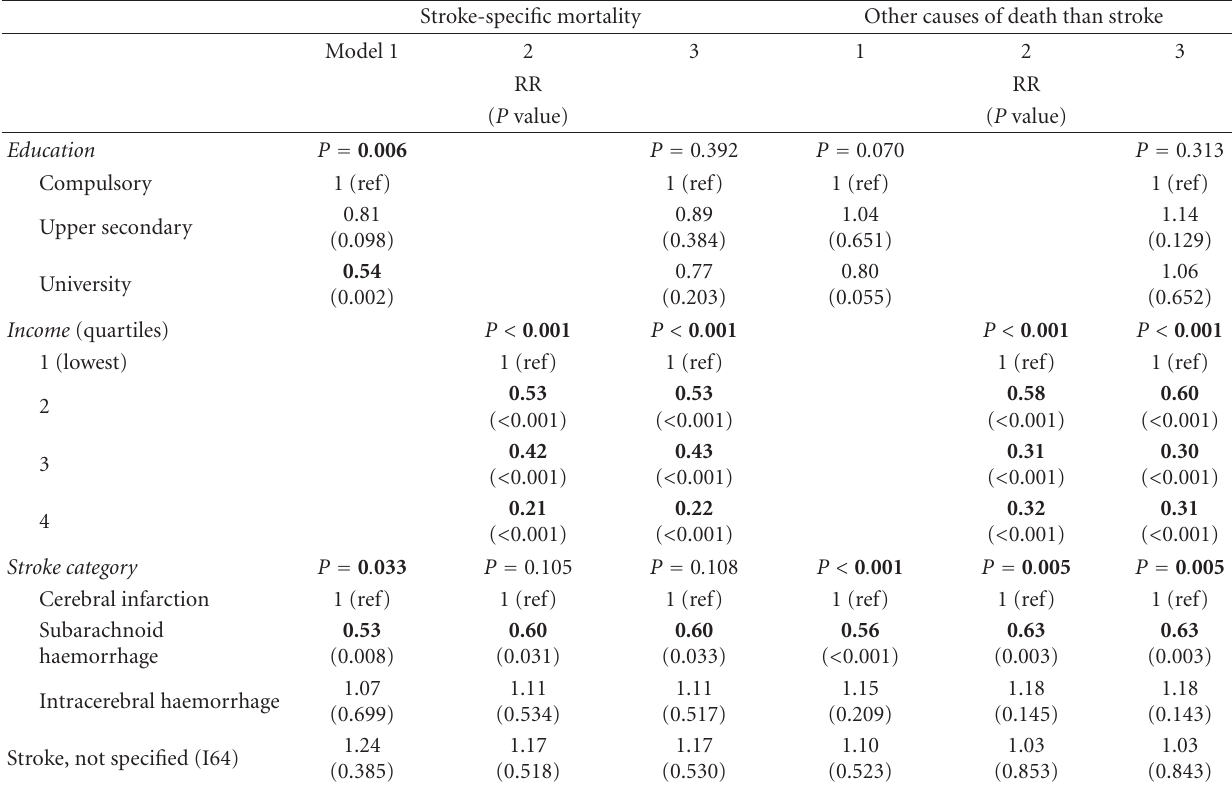
Table 2: Relative risk of dying after a stroke ( n =